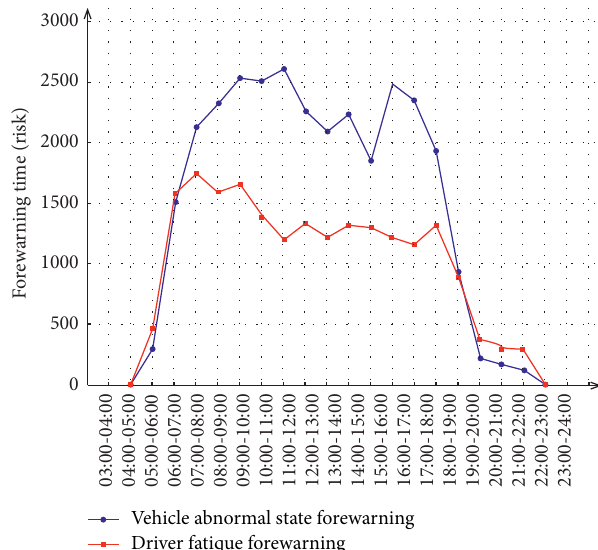
Figure 5: Time distribution characteristics of different forewarning types and number of